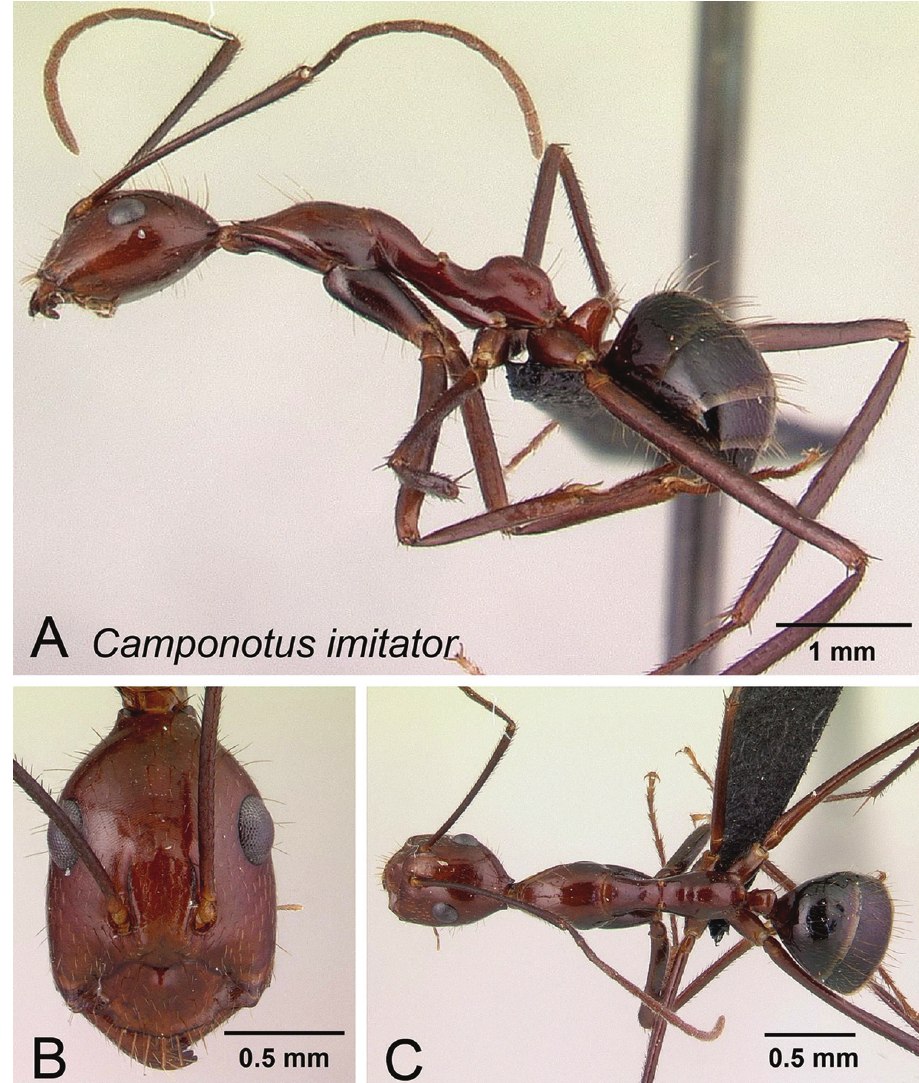
Figure 9. Camponotus imitator minor worker CASENT0452849. A Lateral view B Head in full-face view C Dorsal